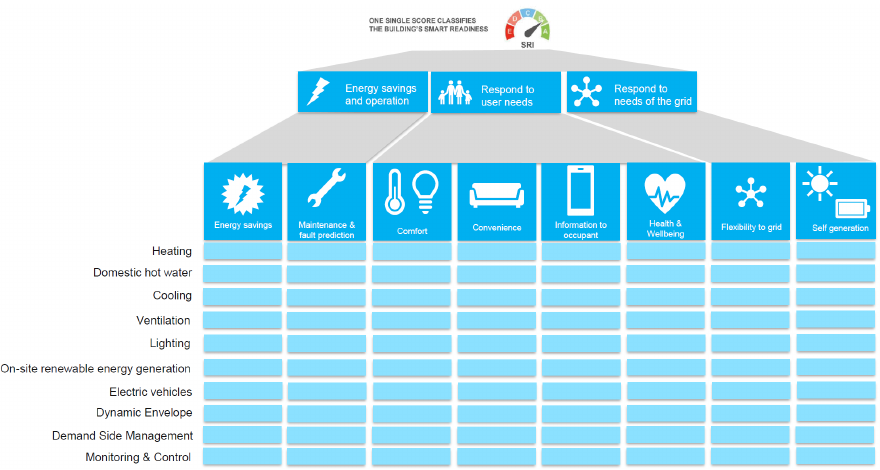
Figure 1. The technical domains, the impact criteria and the corresponding explicit weightings of the EU SRI framework